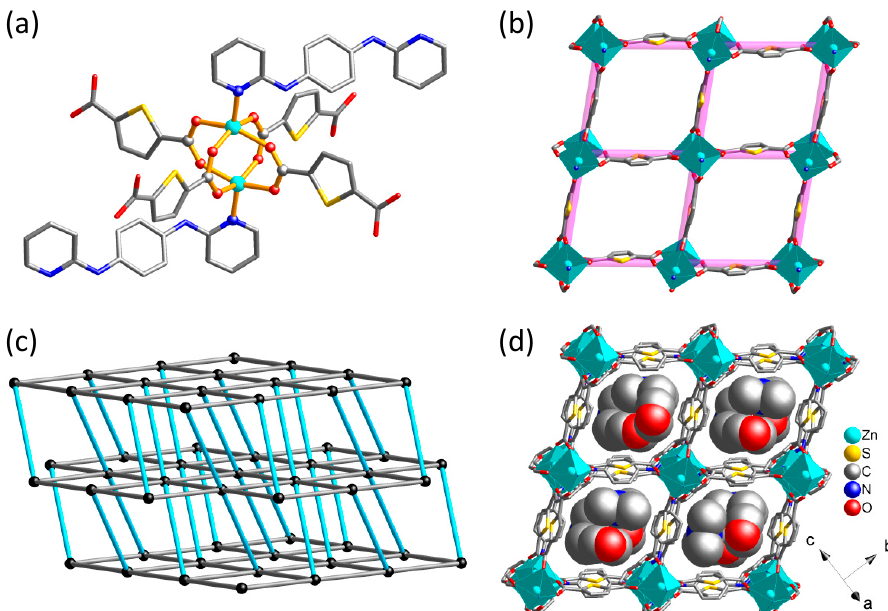
Figure 2. The molecular structure of 3 : ( a ) Coordination environment around Zn(II) center; ( b ) a single 2D Zn–thdc 4 4 - sql layer; ( c ) schematic representation of the whole 6-connected non-interpenetrated pillared-layer framework of 4 8 · 6 6 · 8-topology; ( d ) packing diagram viewed down the crystallographic [101] direction, showing lattice DMF molecules inside the solvent accessible